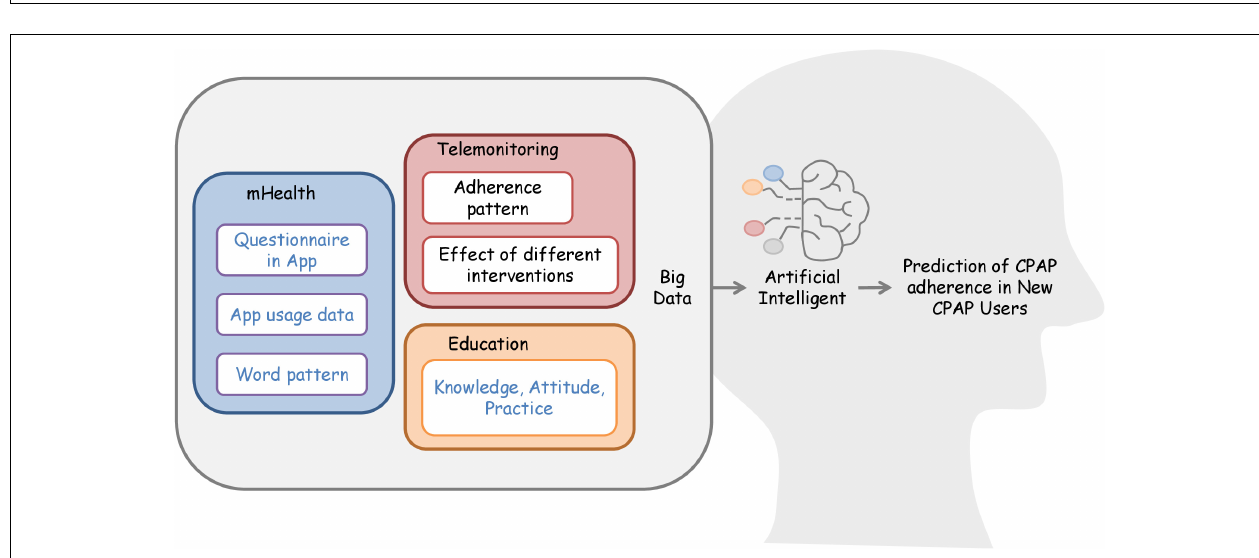
FIGURE 1 | Flowchart for future telehealth application. New CPAP users receive education and initiate a self-management approach initially. Then, healthcare providers remotely monitor CPAP usage data and identify the patient’s adherence occasionally. For the patient with good adherence, healthcare providers administrate an app for the patient to self-manage. Patients with insufficient adherence should join combining interventions. Currently available interventions include telephone, text message, psychological motivational enhancement, and patient engagement tools. Future studies on continuous tele-education, family engagement tools, and online patient support groups are required. Collection of adherence data able to build big data. Training artificial intelligence with big data might help to predict adherence of new CPAP users. Blue words and dotted lines represent future interventions.